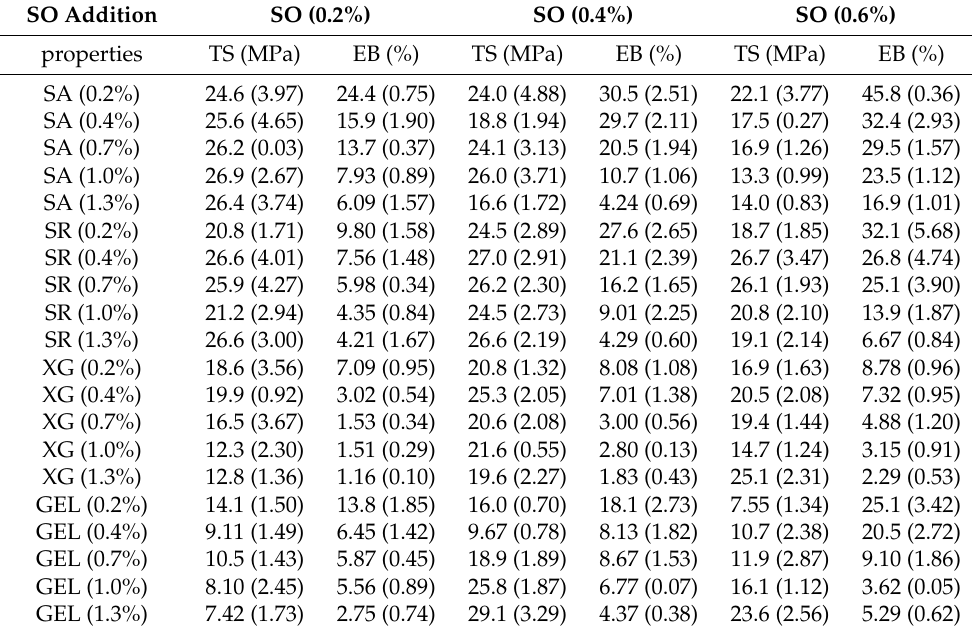
Table 2. The effect of SO addition on the tensile strength (TS) and elongation at break (EB) of the composite